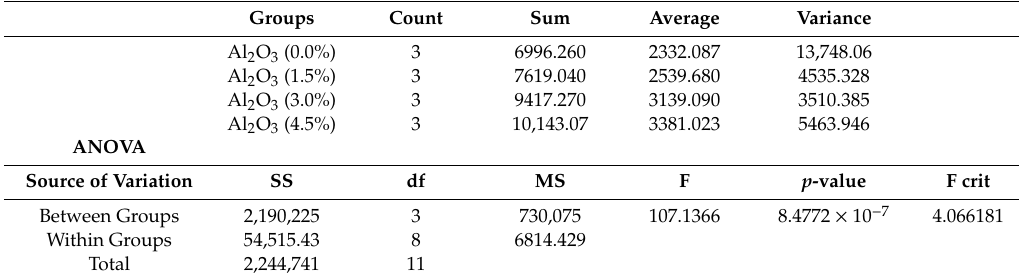
Table 4. MOE values of Al 2 O 3 -UF MDF for various treatments.